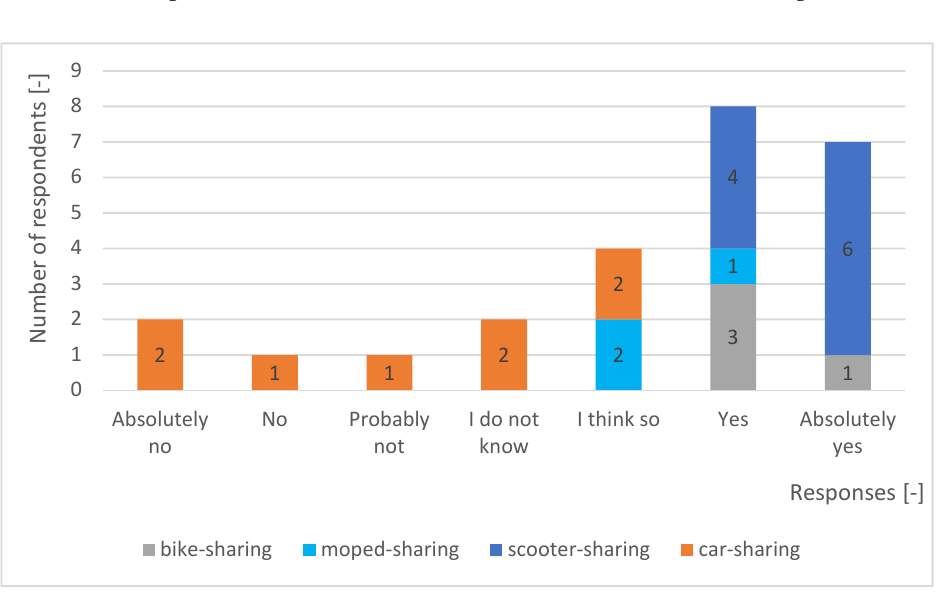
Figure 5. Anticipating whether open innovation and MaaS will be the future of shared mobility Figure services.